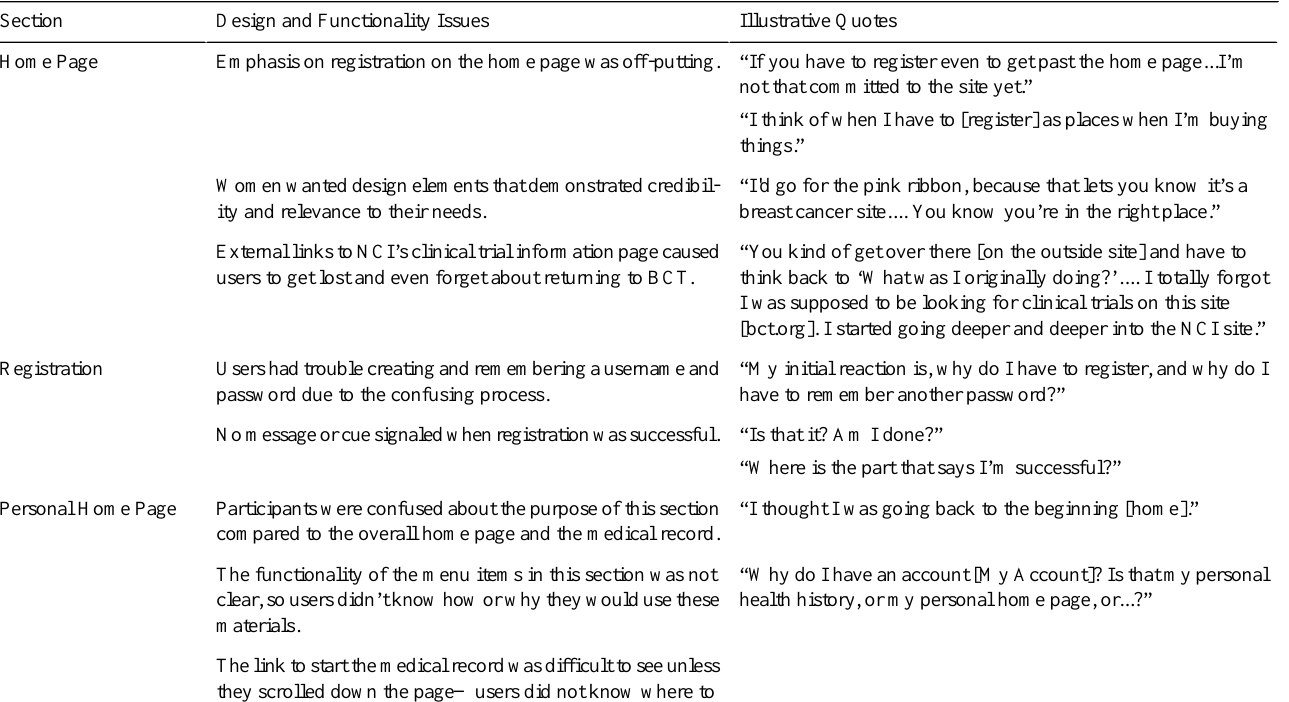
Table 3. Design and functionality issues of prototype system for phase 2 participants